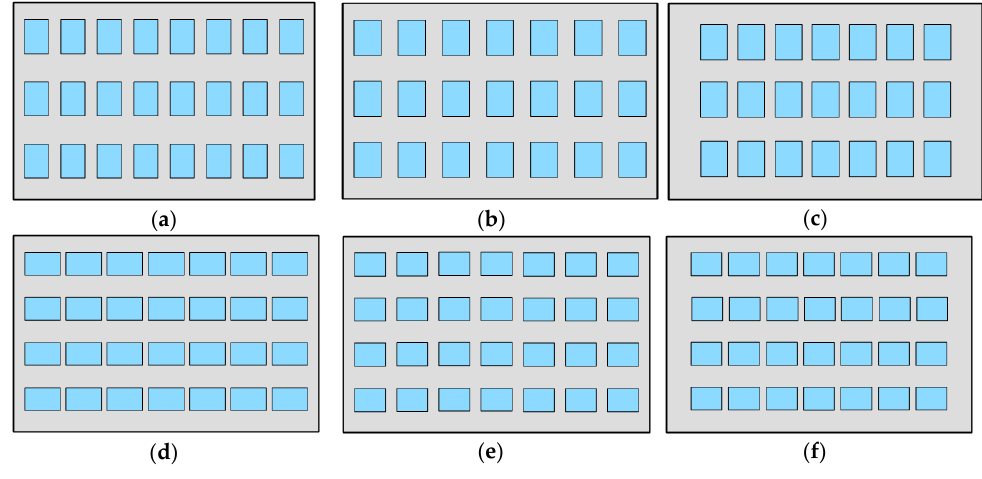
Figure 2. Six different options of typification of the example façade in Figure 1: ( a ) Option 1: constraints 2, 3 and 4; ( b ) Option 2: constraints 1, 2 and 4; ( c ) Option 3: constraints 1, 2 and 3; ( d ) Option 4: constraints 3, 4 and 5; ( e ) Option 5: constraints 1, 4 and 5; ( f ) Option 6: constraints 1, 3 and 5.